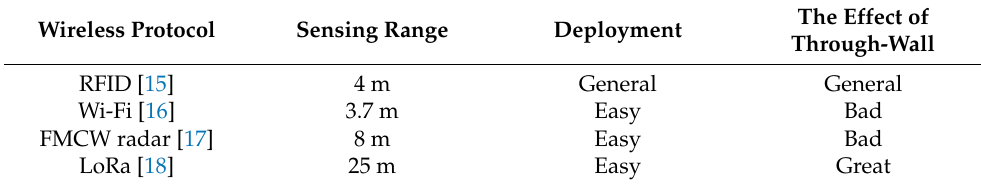
Table 1. Several common wireless protocol parameters.